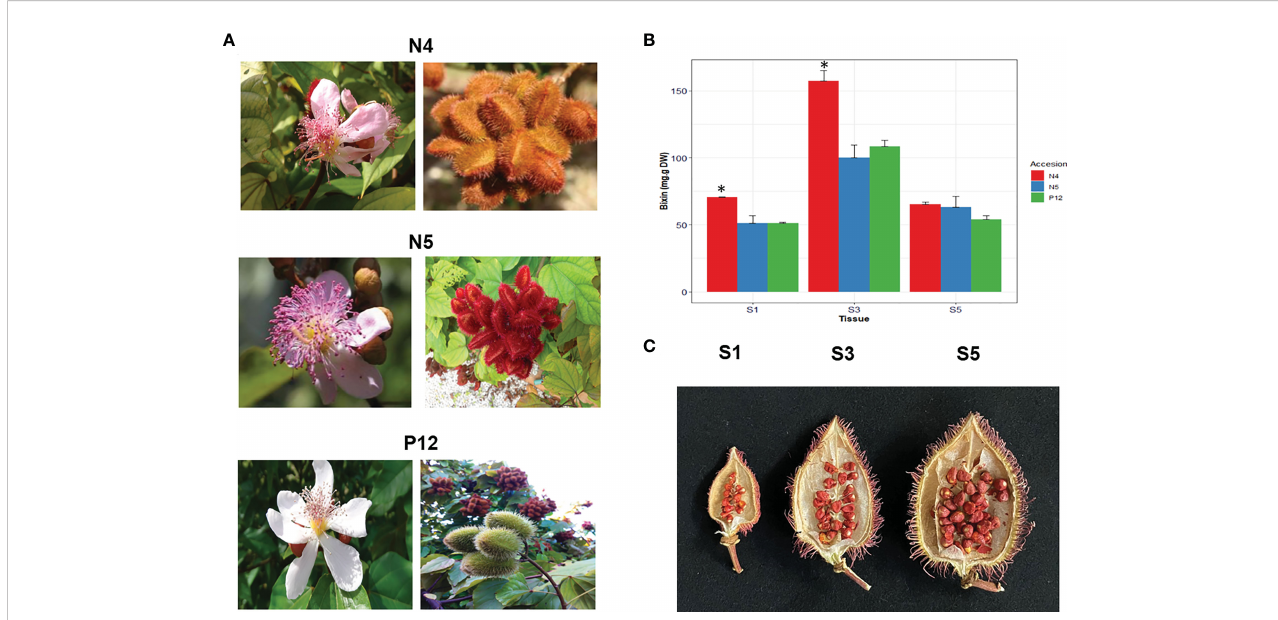
FIGURE 1 B . orellana morphotypes and bixin accumulation. (A) Flowers and fruits show the characteristics of the accessions used in the current study. (B) Bixin accumulation in the different seed development by stage in the different B . orellana accessions show signi fi cant differences (*) in the N4 accession. (C) Representative S1, S3, and S5 seed stage in the N4